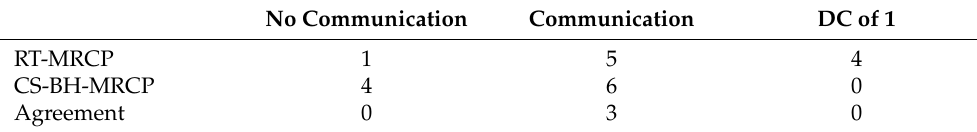
Table A7. Visualization of a communication between the pancreatic cyst and the main pancreatic duct based on the consensus between the two readers based on the consensus between the two readers: Number of patients ( n = 10) with or without visible communication on RT-MRCP and CS-BH-MRCP images (only for images with confidence diagnostic of 2 or